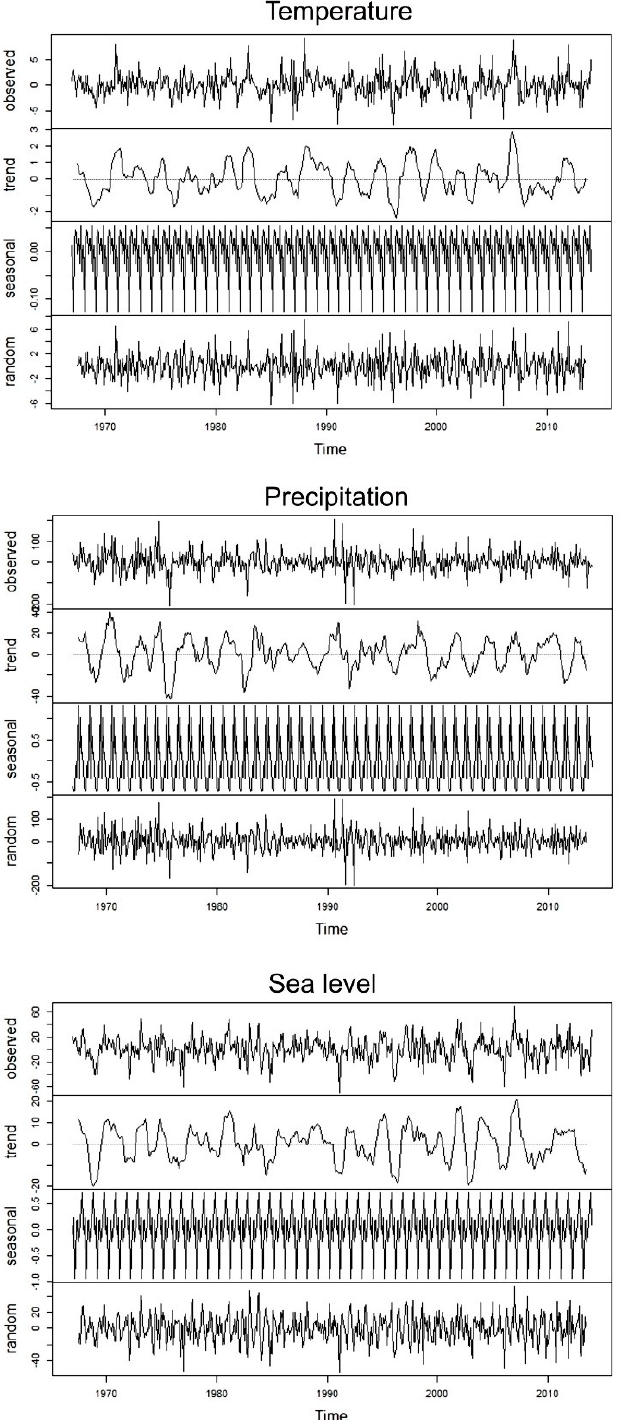
Figure 3. Additive decomposition for hydrometeorological conditions in Ustka (monthly intervals from 1966–2015).